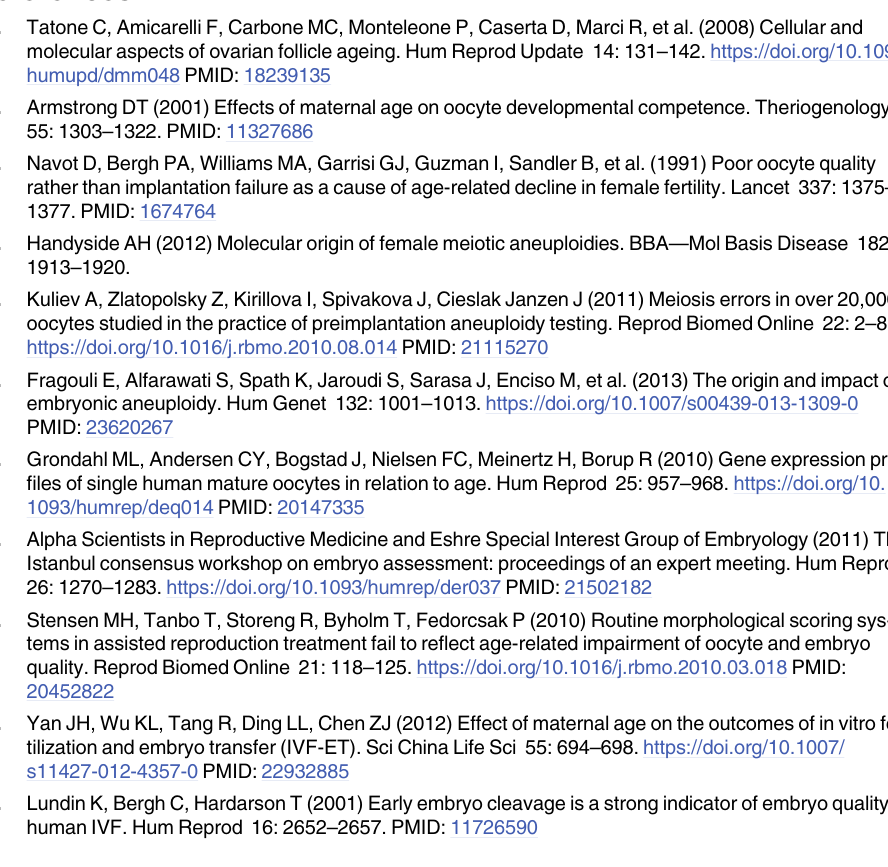
S1 Table. Data Groendahl et al.